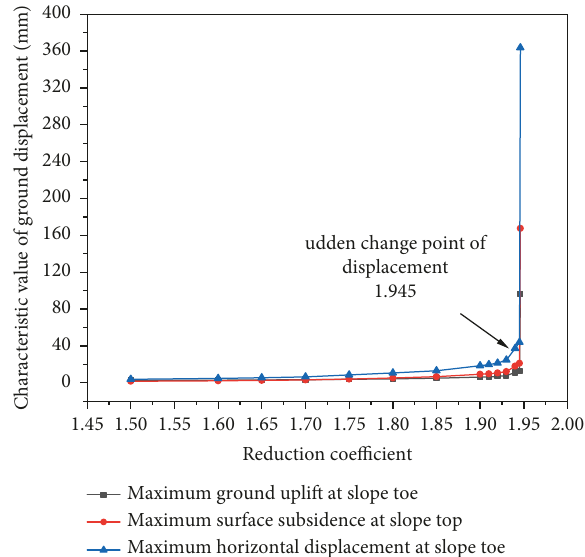
Figure 14: Variation law for slope deformation characteristic value with reduction